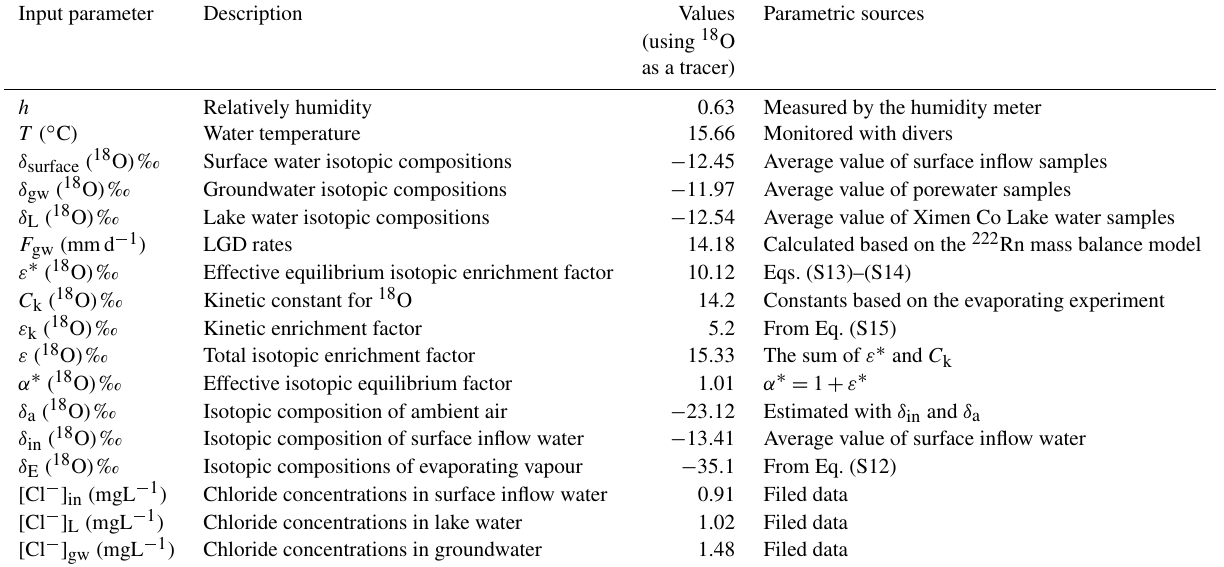
Table 2. Input parameters for the three-endmember model of Ximen Co